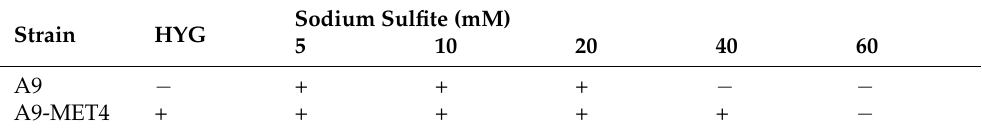
Table 2. The genotype and sulfite resistance ability of MET4 transgenic strain and its starting stain.